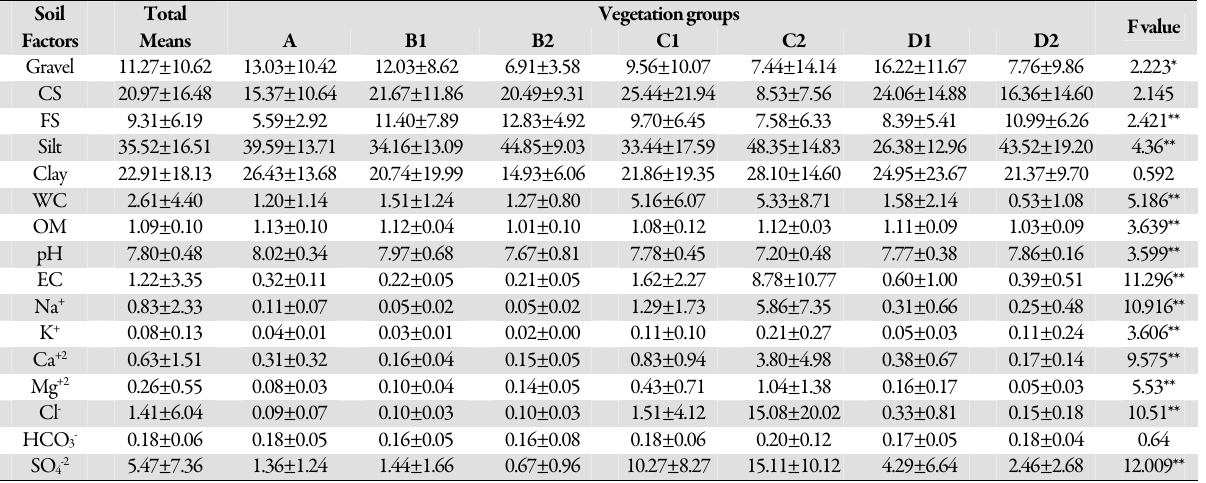
Tab. 3. Mean values, standard deviations (±SD) and ANOVA values of the soil variables in the vegetation groups (A-D2) of the study area. EC=Electrical conductivity (mS.cm -1 ), soil fractions (%), CS=Coarse sand, FS=Fine sand, OM=Organic matter, Na + , K + , Ca +2 , Mg +2 , Cl - and HCO 3- (mg.g -1 d.wt. soil), SO 4-2 (µg.g-1 d.wt. soil), OM (%), *= p<0.05, **=